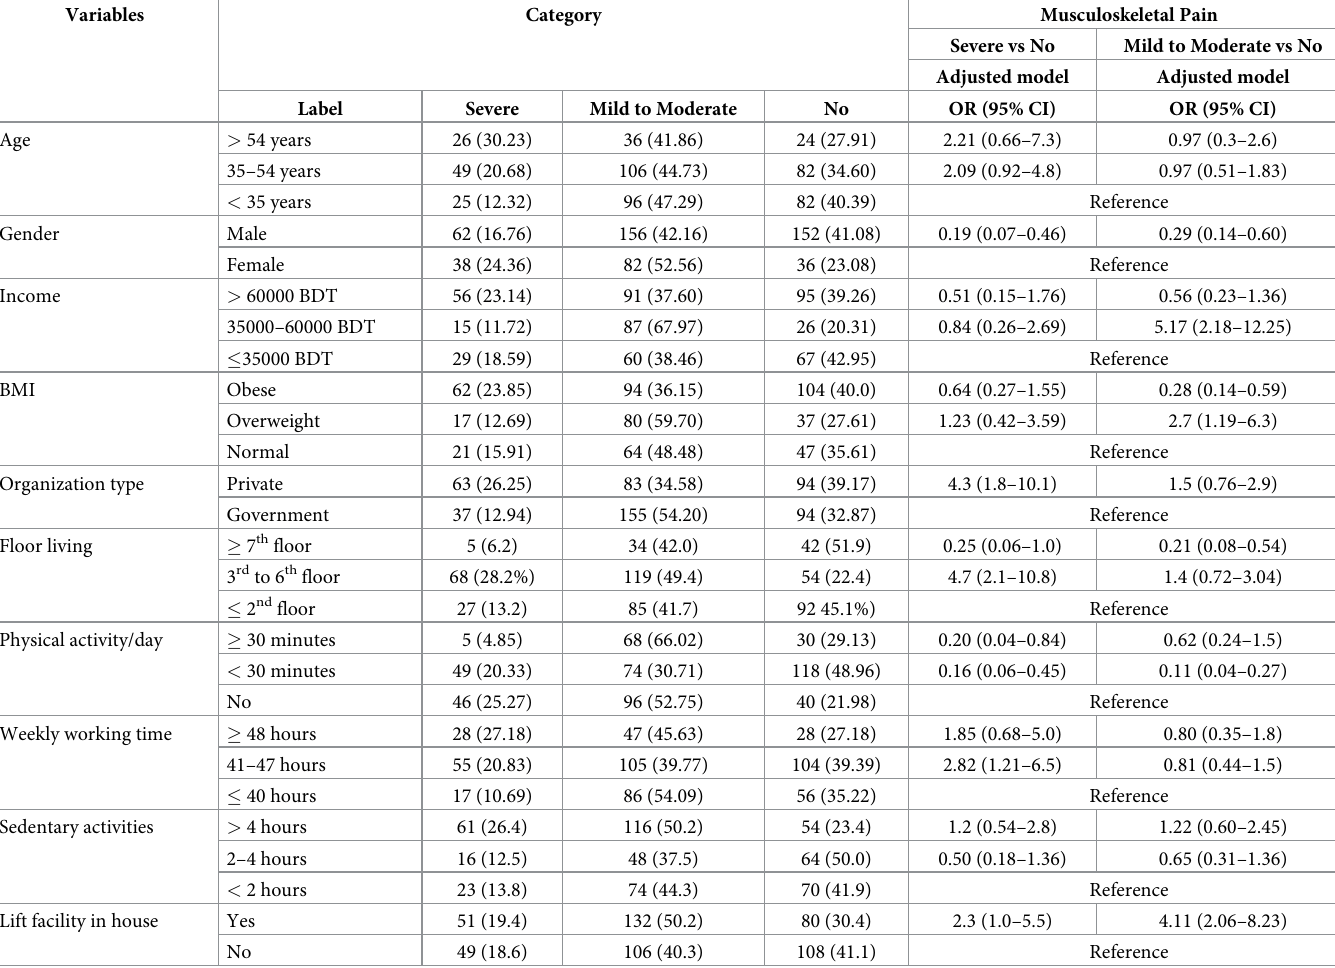
Table 2. Logistic regression analysis of sociodemographic characteristics and musculoskeletal pain (multinomial logistic regression).